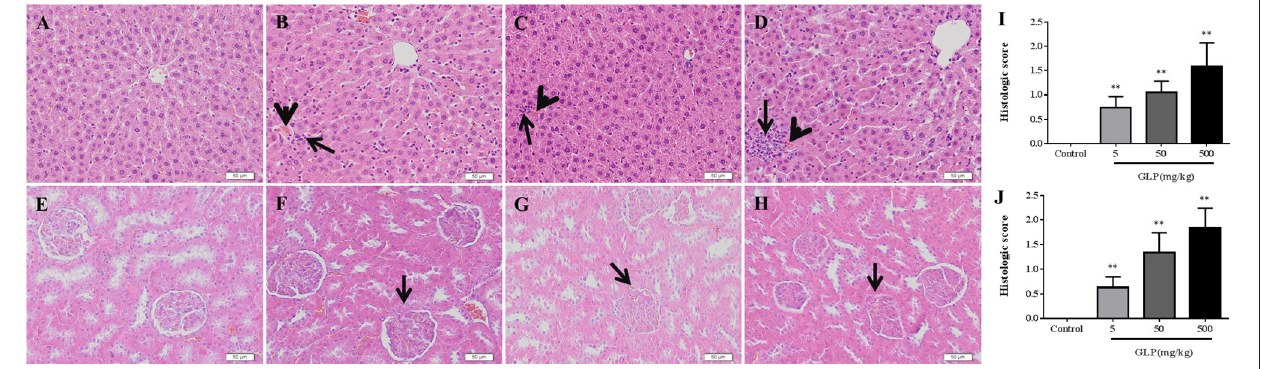
FIGURE 1 | Histopathological changes in the livers and kidneys of male rats following oral GLP administration through Hematoxylin and eosin staining. 200 × magnification. (A) Normal liver section. Hepatic lobules consisting of a central vein surrounded by radiating hepatocytes which were separated; (B–D) GLP (5, 50, and 500 mg/kg/day) treated presenting periportal expansion, structural disorder, monocyte infiltration (arrows), and congestion (arrowheads). (E) Normal kidney section. No signs of kidney damage were observed in the kidney of controls; (F–H) GLP (5, 50, and 500 mg/kg/day) treated presenting proximal and distal tubular necrosis and glomerular toxicity (arrows). (I,J) The hepatic and renal damages histologic score evaluating. Data shown are mean ± SEM of six liver sections in each group. Compared to control; ** p <